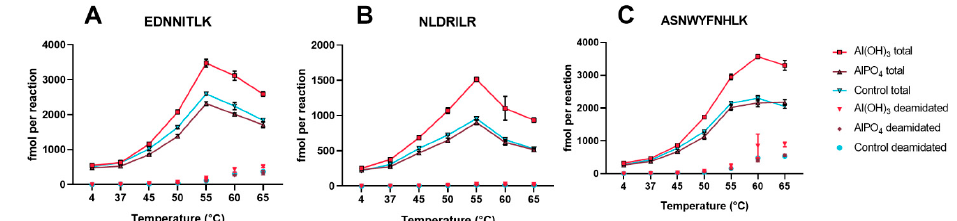
Figure 8. Temperature sensitive formation of peptides ( A ) EDNNITLK, ( B ) NLDRILR, and ( C ) ASNWYFNHLK by cathepsin S from Al(OH) 3 and AlPO 4 adsorbed tetanus toxoids. Connected lines show the sum of the native and the deamidated peptides, single points indicate the sum of all variants of the deamidated peptides. Error bars represent SD of three individually adsorbed samples.